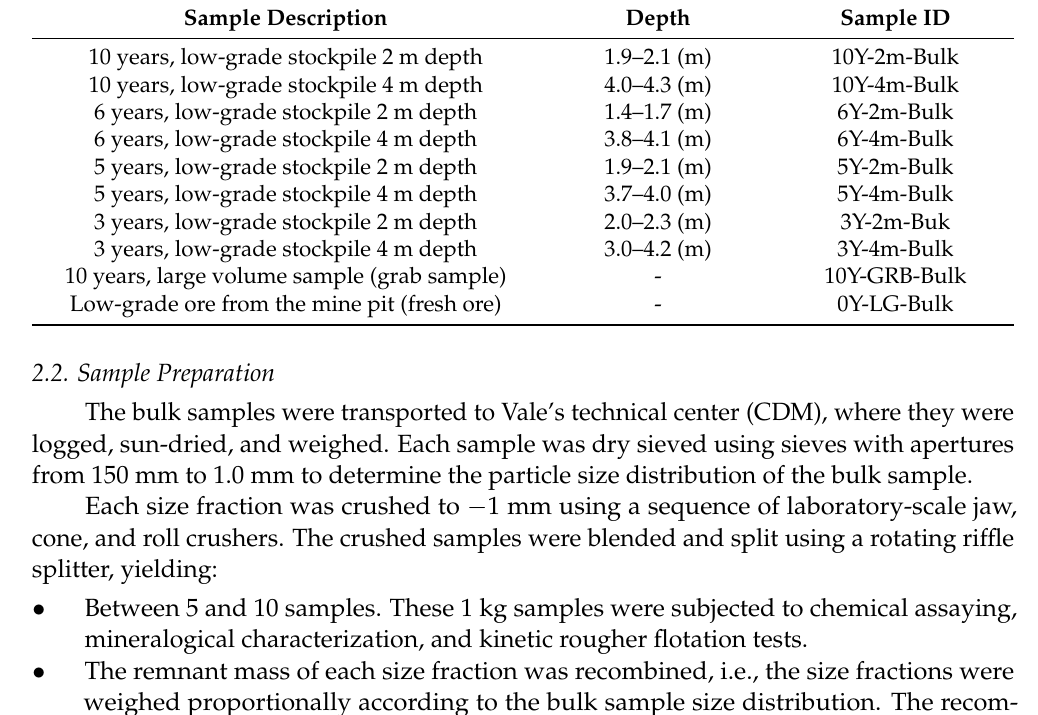
Table 1. List of samples, showing the period of stockpiling and the depth from which they were collected in the stockpile.